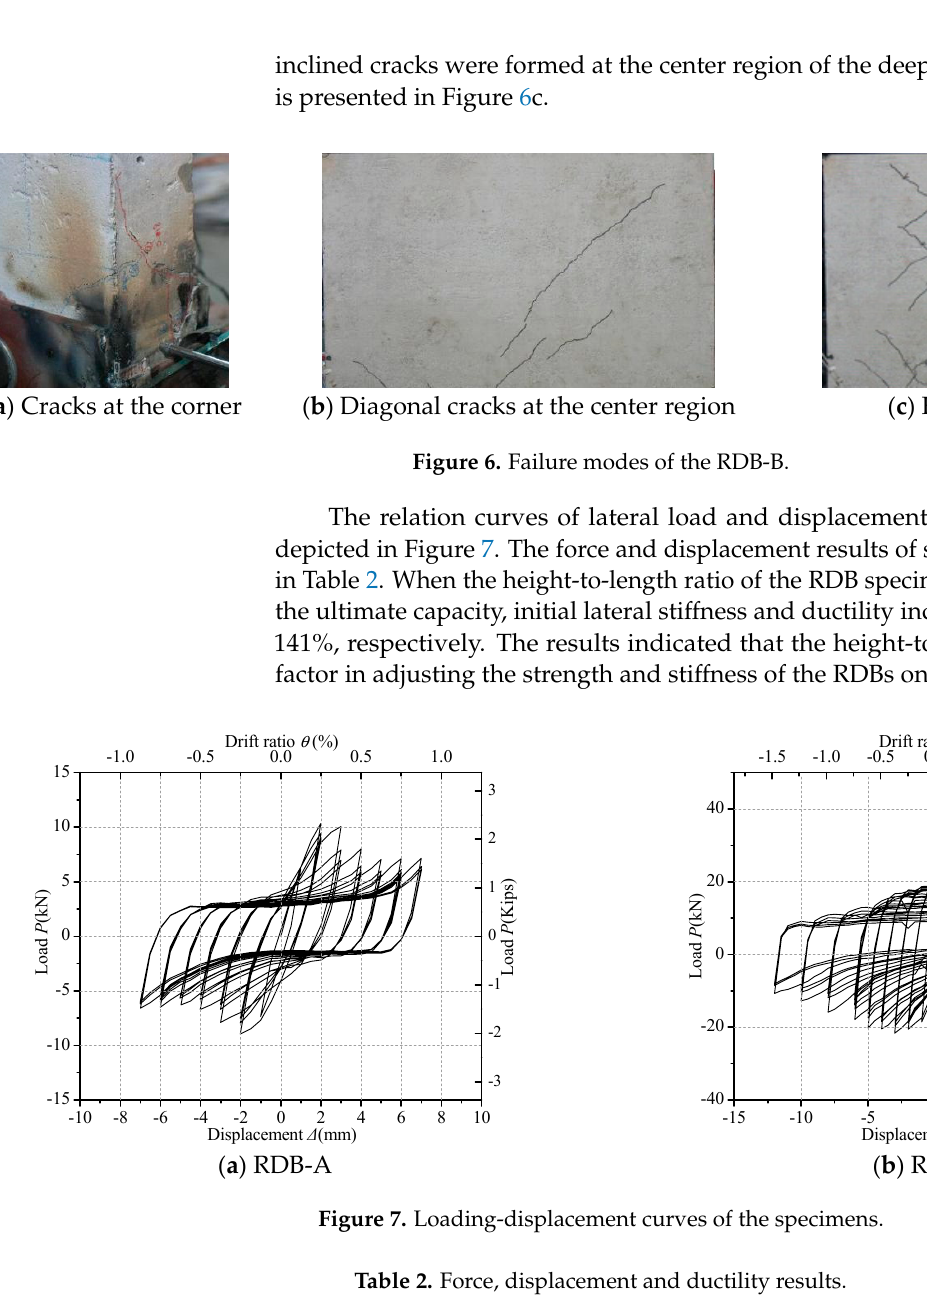
( c ) Failure of the RDB-A Figure 5. Failure modes of the RDB-A.